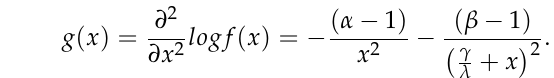
Figure 3. 𝑔(𝑥) for 𝑊𝐷(0.5,4,1,1), and 𝑊𝐷(1.5,−4,1,1) . The distributions with log-concave density are unimodal and have increasing failure rate property. Theorem 5. I.